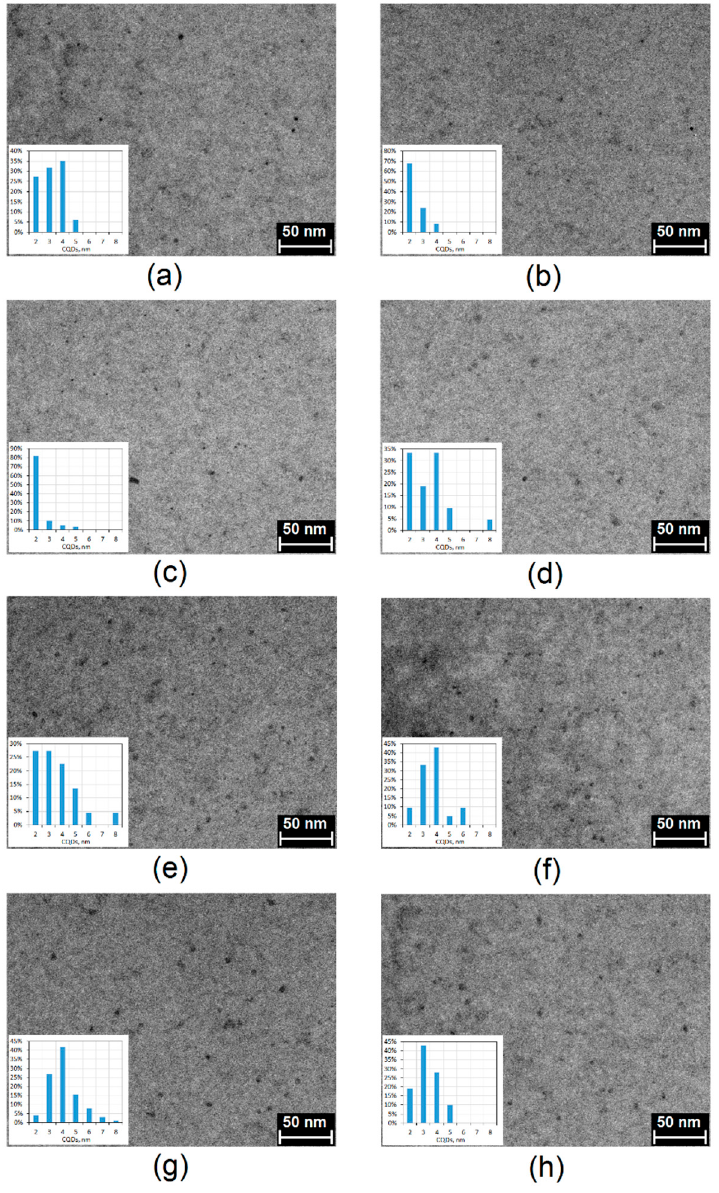
Figure 6. TEM images of the prepared CQDs: ( a ) CQDs-1; ( b ) CQDs-2; ( c ) CQDs-3; ( d ) CQDs-4; ( e ) CQDs-5; ( f ) CQDs-6; ( g ) CQDs-7; ( h ) CQDs-8.